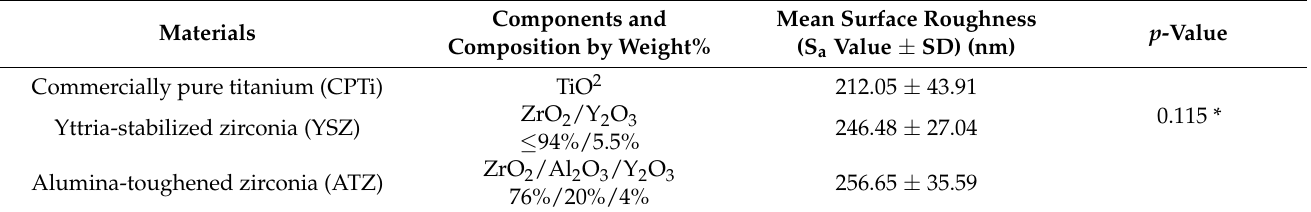
Table 1. Surface roughness and composition of materials used in this